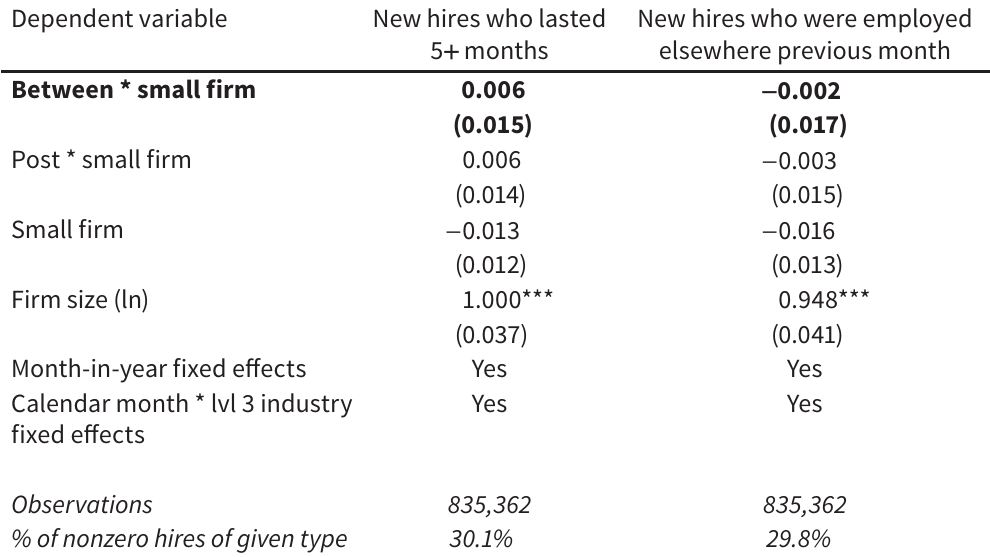
Policy effect on long-term hires and employees moving between firms Dependent variable New hires who lasted New hires who were employed 5 + months elsewhere previous month Between * small firm